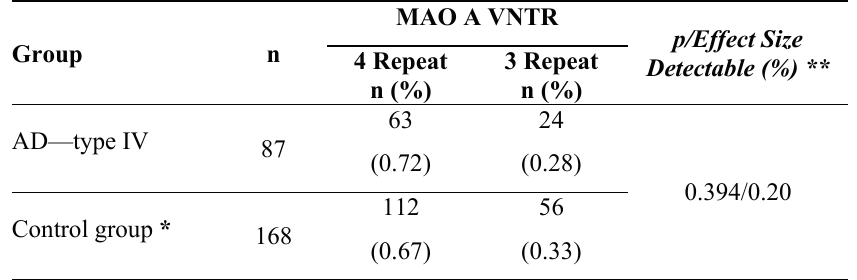
Table 5. Frequency of genotypes of the polymorphism uVNTR of the MAOA gene in patients with alcohol dependence (AD) with Lesch type IV and in